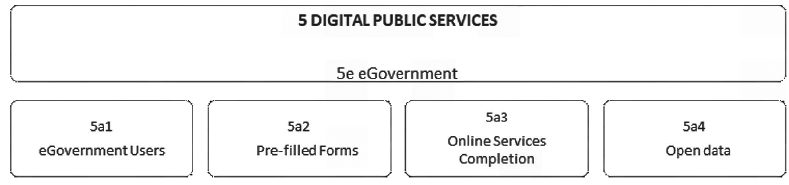
Figure 6. Indicators of digital public services in